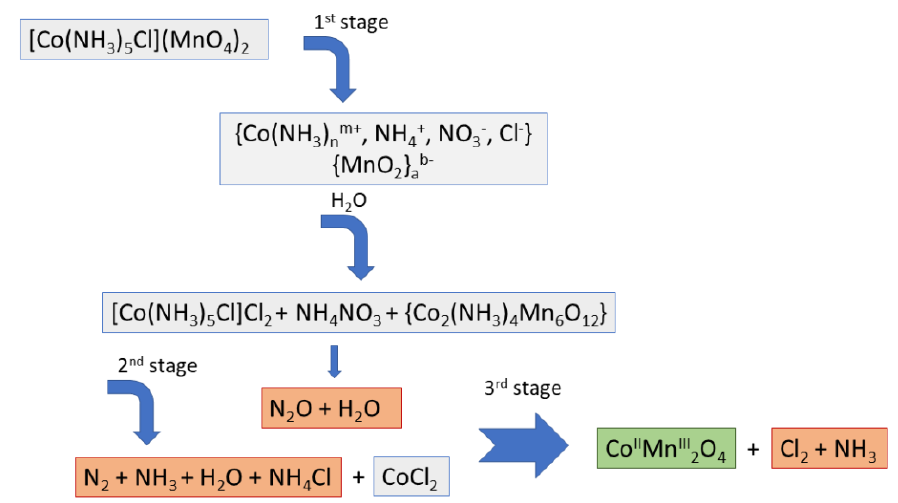
Scheme 1. Thermal decomposition of compound 3-Mn . Grey: solid intermediates; brown: gaseous decomposition products; green: solid decomposition product.